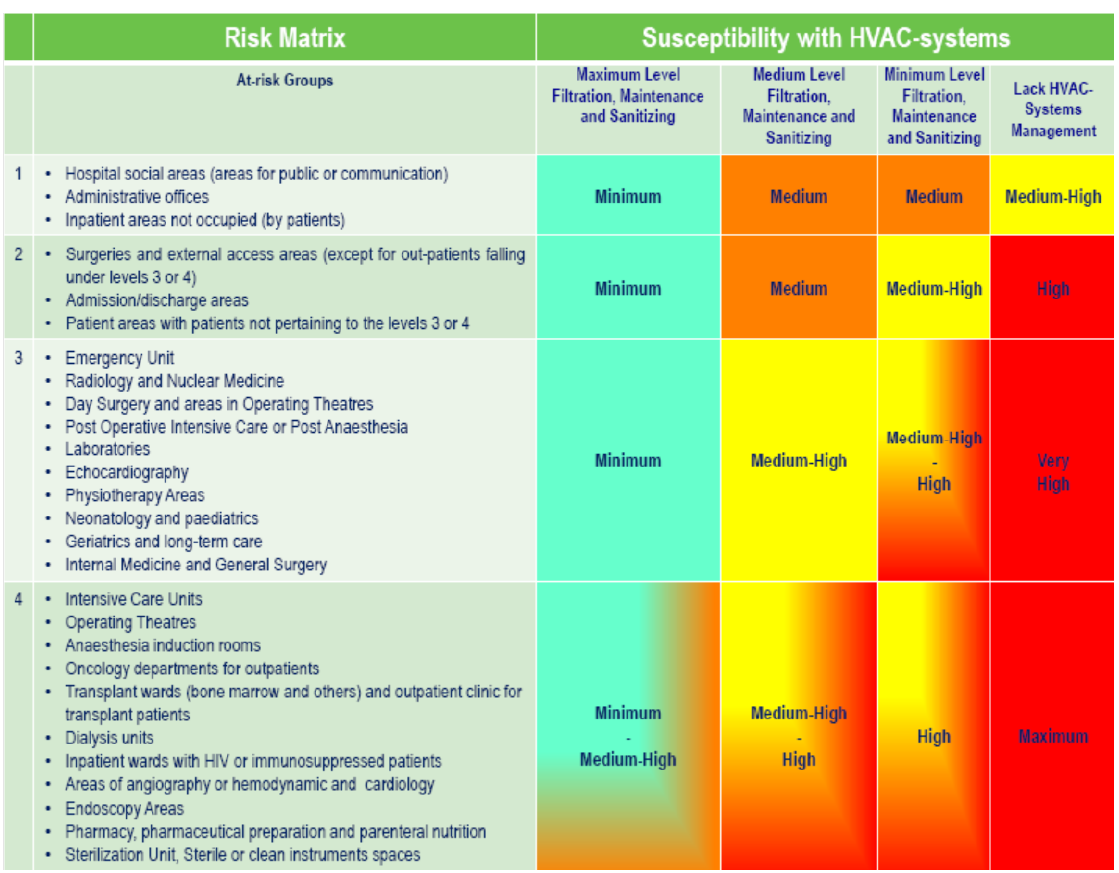
Figure 2. Matrix of the risk level to which the patient is exposed in air conditioned hospital environments [47].